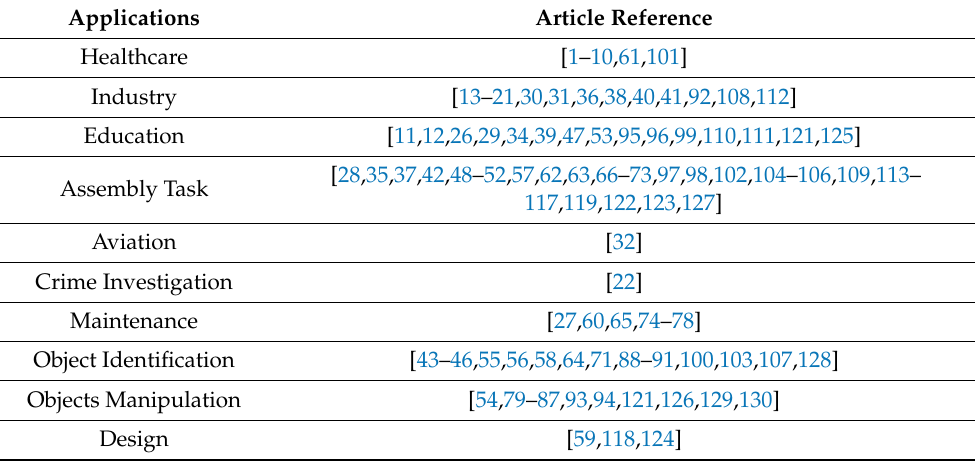
Table 4. Applications of remote collaboration